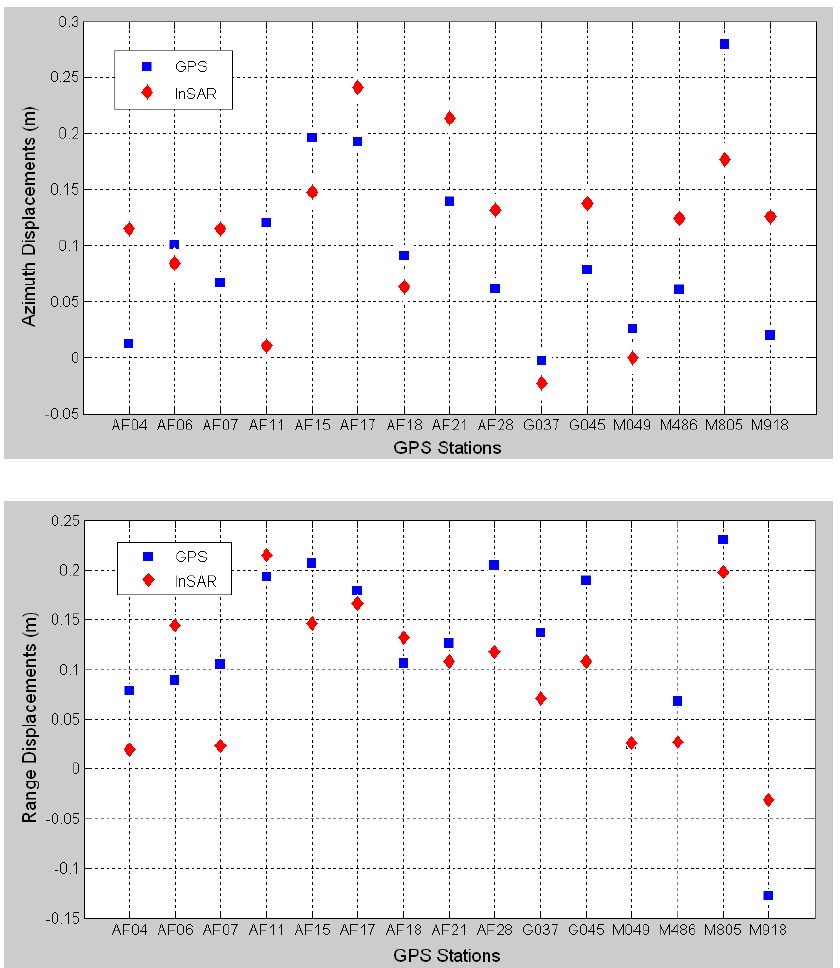
Figure 7. Comparisons between the displacements observed with GPS and from the method of amplitude image matching in azimuth (up) and range directions (low). The GPS stations used for the comparison are listed in Figure 4. The RMS values of the differences between the results are 6.9 cm and 5.7 cm, respectively, in the two